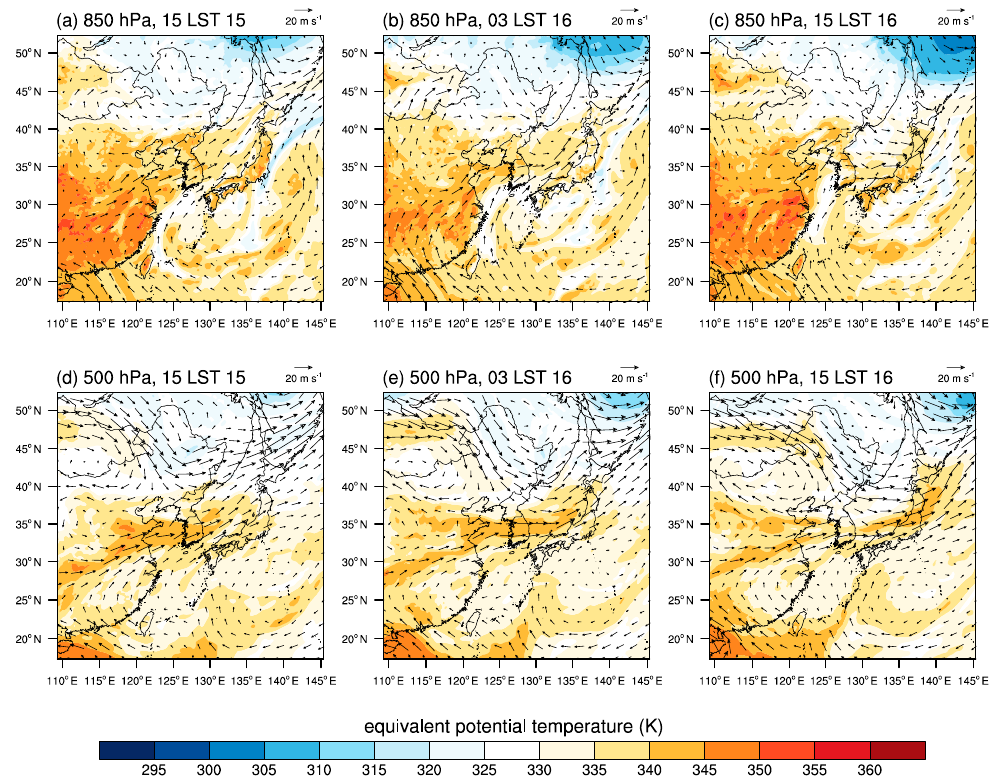
Figure 1. 850 hPa equivalent potential temperature (K, shaded) and horizontal wind (m s − 1 , arrows) fields at ( a ) 15 local standard time (LST) 15, ( b ) 03 LST 16, and ( c ) 15 LST 16 July 2017 using the National Centers for Environmental Predictions (NCEP) Final (FNL) 0.25-degree analysis data. Subfigures ( d – f ) are analogous to ( a – c ) but at 500 hPa.